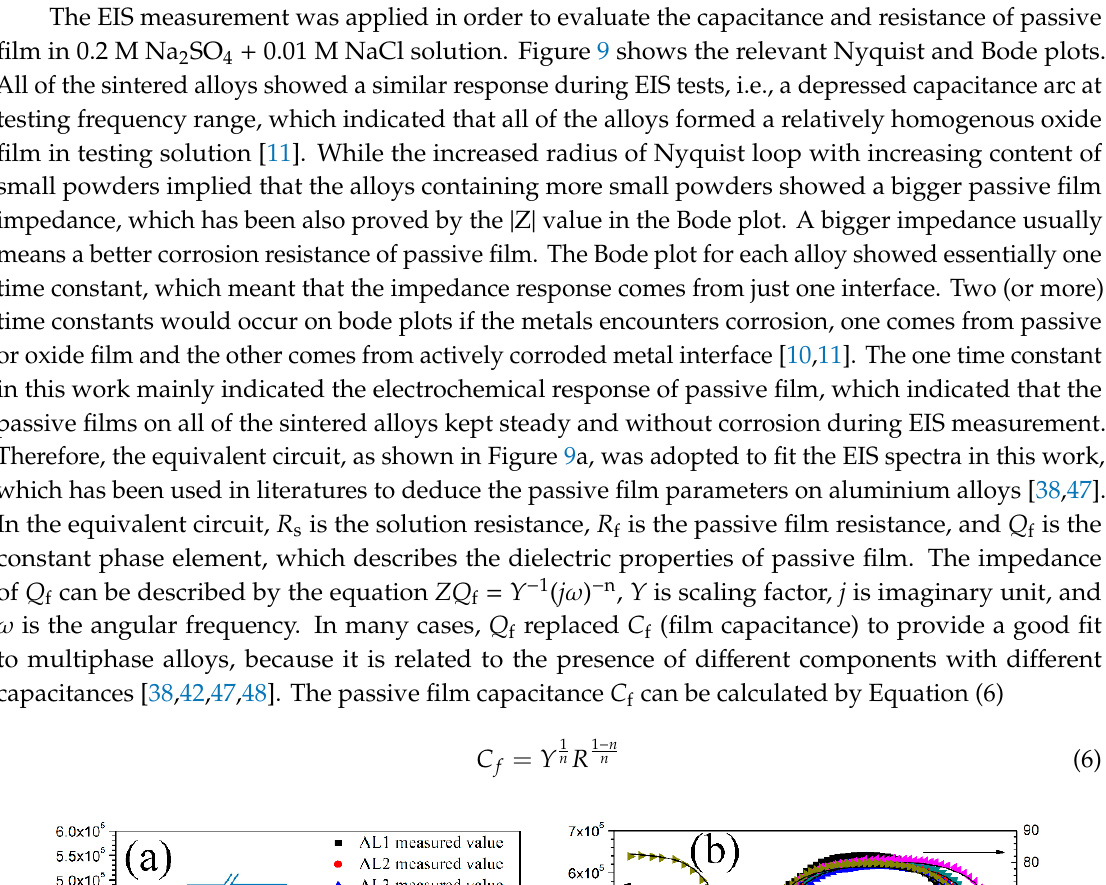
(7) Table 3. The fitted results of EIS plots about the passive film formed on sintered alloys in 0.2 M Na 2 SO 4 + 0.01 M NaCl solution, the standard deviation coms from five valid parallel results. Alloy